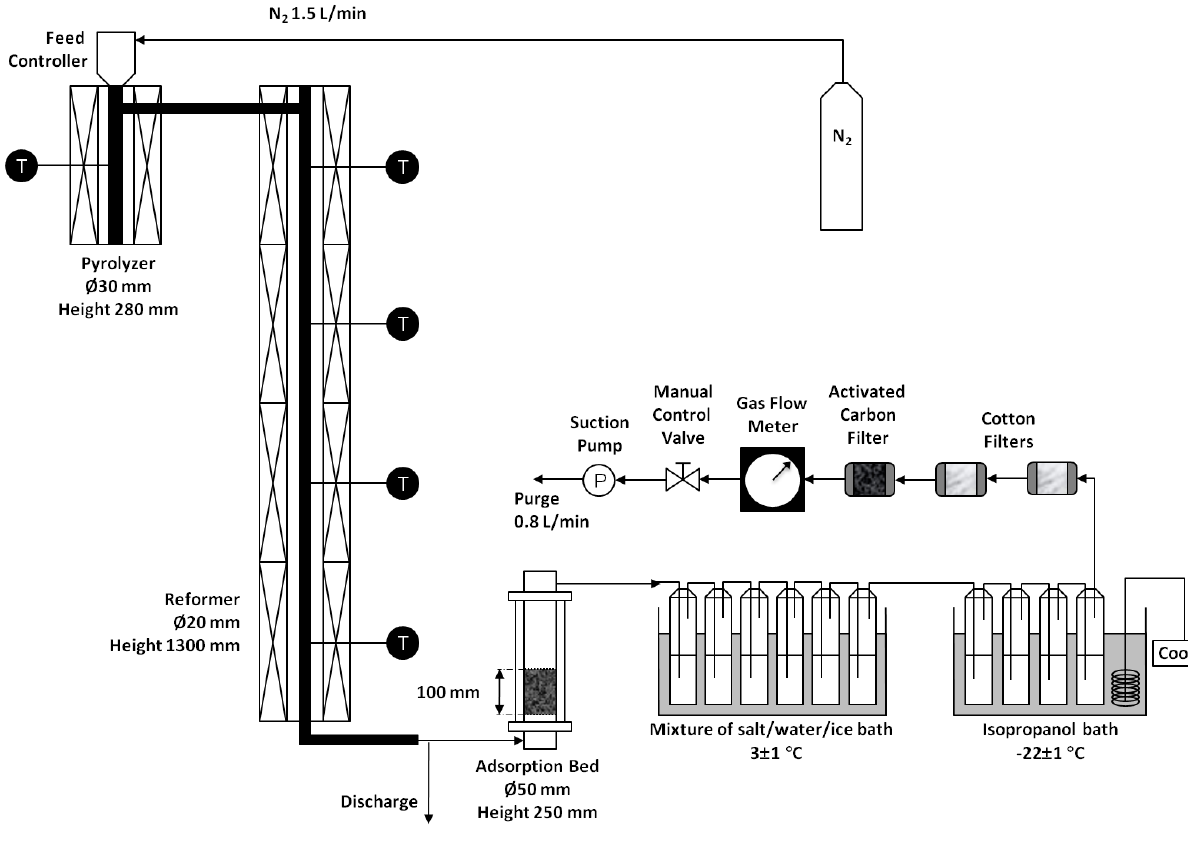
Figure 3. Experimental setup for tar removal